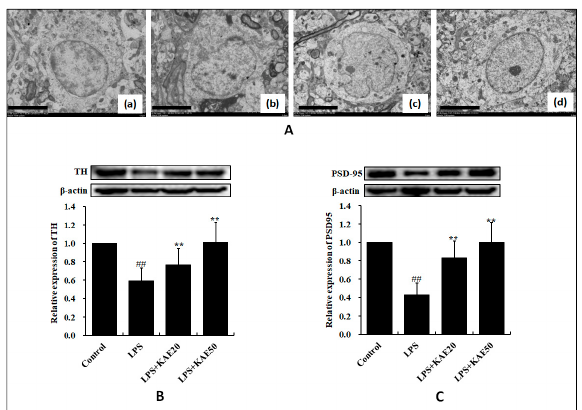
Figure 1. Effect of kaempferol on the striatum of of mice injured by lipopolysaccharide (LPS). ( A ) Electron microscopy analysis of the ultrastructure alterations in striatum derived from the various treatment groups: control group ( a ), LPS group ( b ), LPS+KAE 20 mg/kg group ( c ); LPS+KAE 50 mg/kg group ( d ); ( B ) Expression of TH protein; and ( C ) Expression of PSD ‐ 95 protein. Values are mean ± SD ( n = 4). ## p < 0.01 vs. Control group. ** p < 0.01 vs. LPS group. Scale bars 5 μ m in ( a – d ), n = 3 per group.